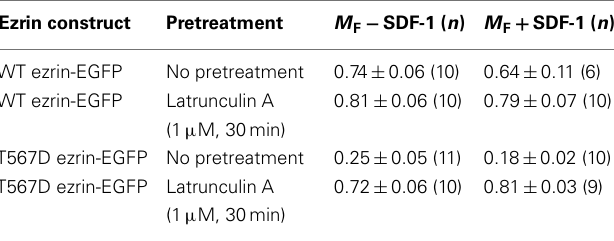
Table 1 | Lateral mobility of wild type ezrin andT567D ezrin-EGFP assessed with fluorescence recovery after photobleaching (FRAP) in humanT cells a